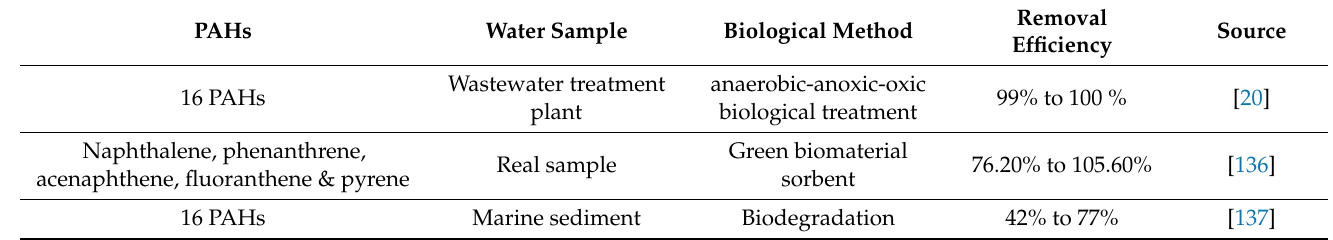
Table 7. Biological methods for removal of PAHs from water sources.